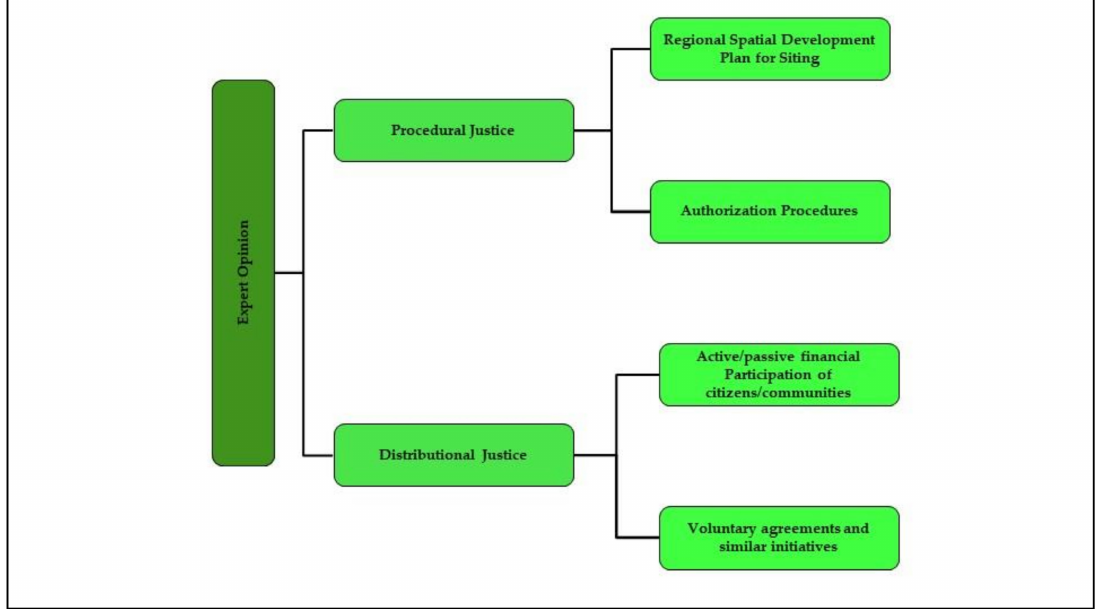
Figure 2. Structure of the expert assessment illustrating di ff erent levels of analysis. Each of the two dimensions “Procedural justice” and “Distributional justice” has been divided into 3 categories, assessed separately. Source: authors’